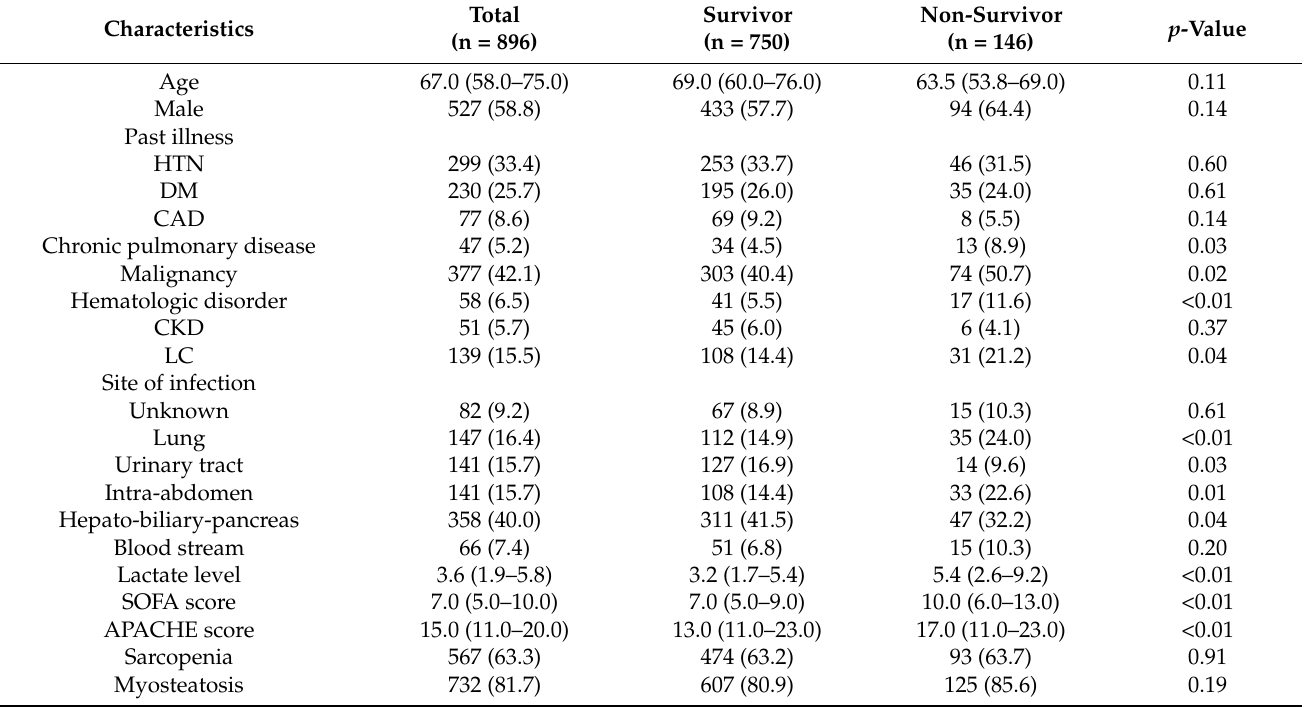
Table 1. Baseline characteristics of the study